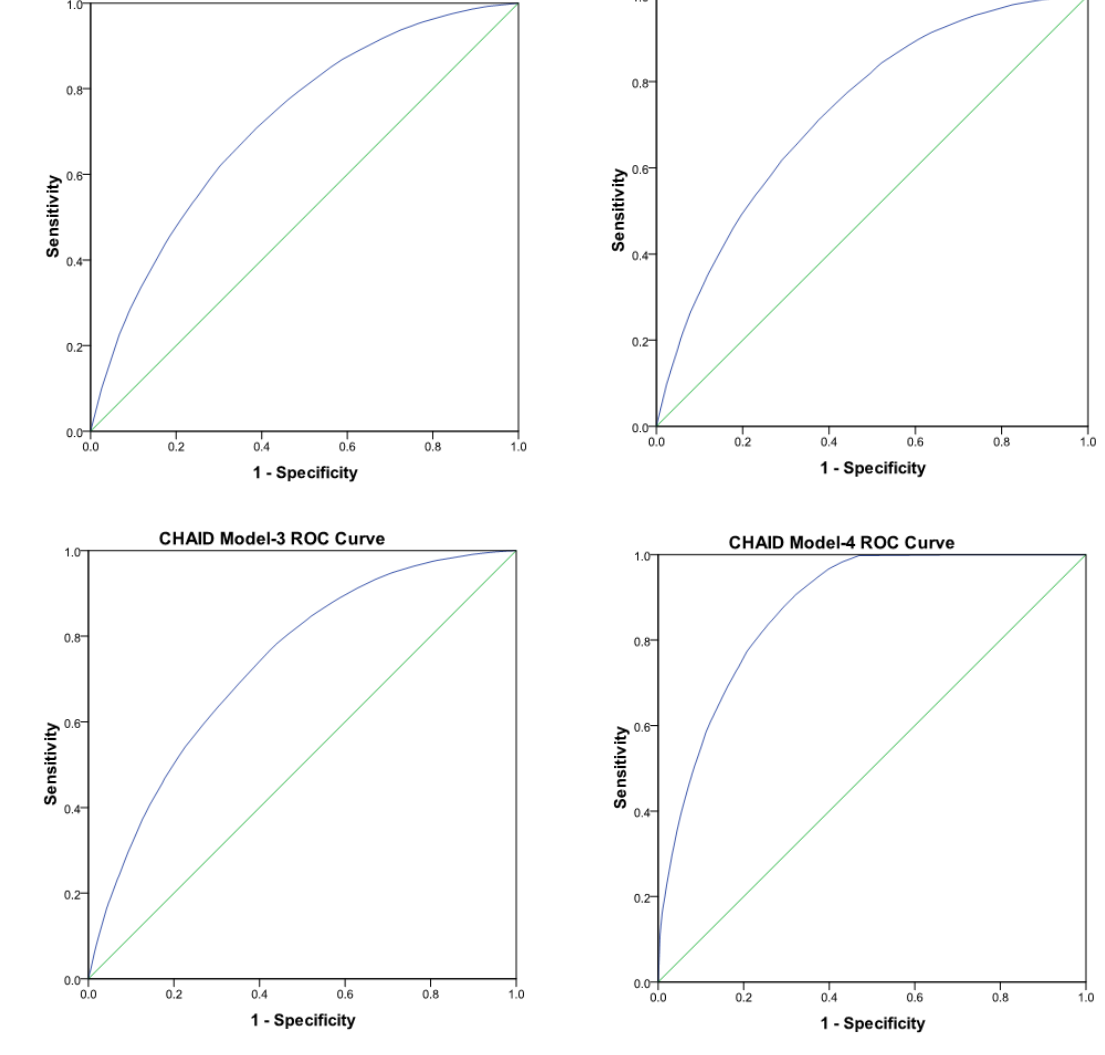
Figure 3. ROC areas for CHAID based Decision